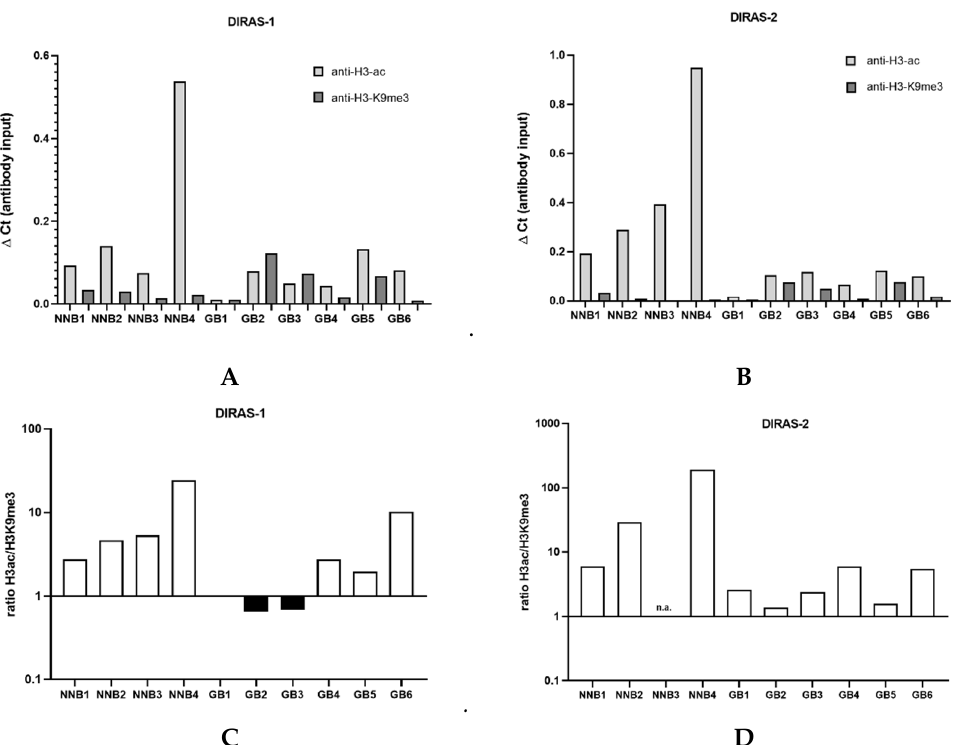
Figure 4. Chromatin immunoprecipitation analysis of glioblastomas and non-neoplastic brain tissues. ( A ) ChIP analysis for DIRAS-1 using anti-H3-ac and anti-H3-K9me3. ( B ) ChIP analysis for DIRAS-2. ( C ) Ratio between H3ac- and H3K9me3-bound DIRAS-1 DNA. ( D ) Ratio for DIRAS-2 DNA. Original figure in Figure S.